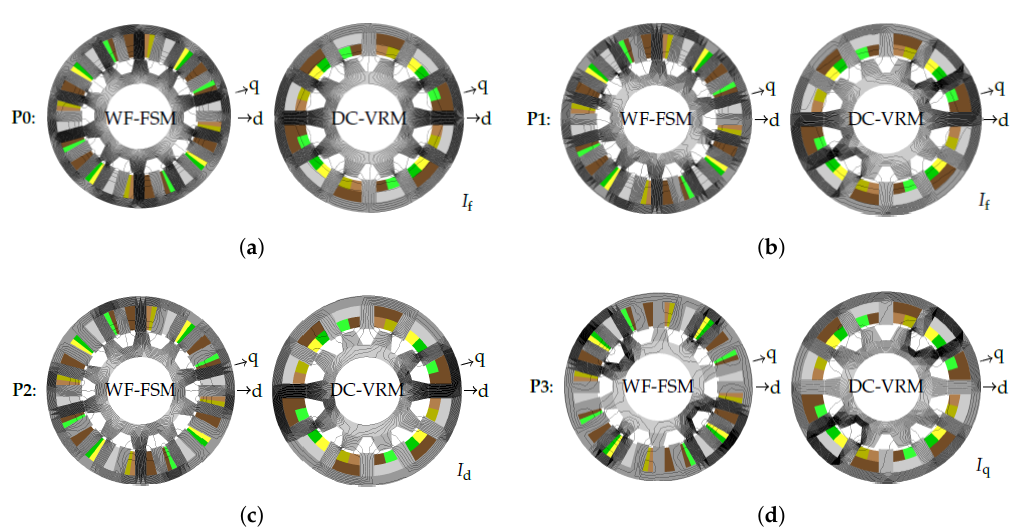
Figure 4. FEM field line solutions at rated current, current angle α = 90 ◦ and given rotor position for ( a ) P0 : only I f current non-linear FEM solution, ( b ) P1 : only I f current linear FEM solution, ( c ) P2 : only I d current linear FEM solution and ( d ) P3 : only I q current linear FEM